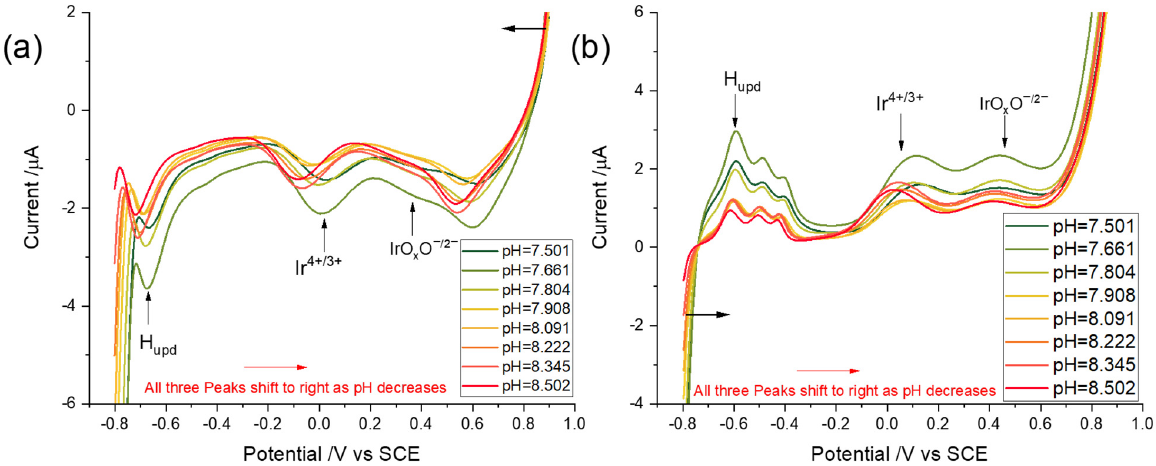
Figure 4. Linear sweep voltammograms with a scan rate of 0.5 Vs − 1 using an activated iridium wire electrode with varying pH of different buffers ranging from 7.50 to 8.50 ( a ) reduction and ( b ) oxidation.